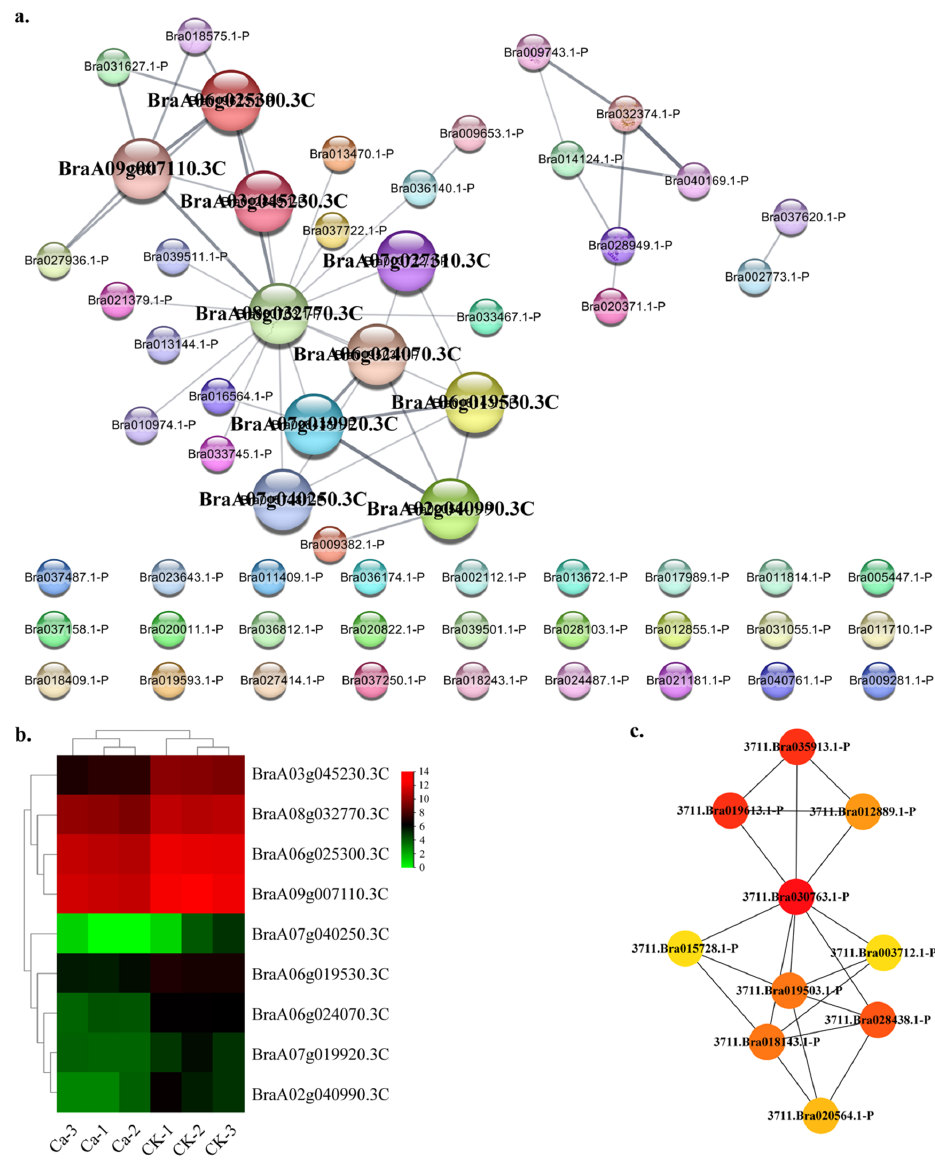
Figure 8. Protein–protein interaction (PPI) analysis in the Ca-related DEGs category. ( a ) PPI network in the Ca category. ( b ) Heatmap of the hub gene expression pattern. ( c ) Hub genes’ interactive relationship of the gene regulatory network.